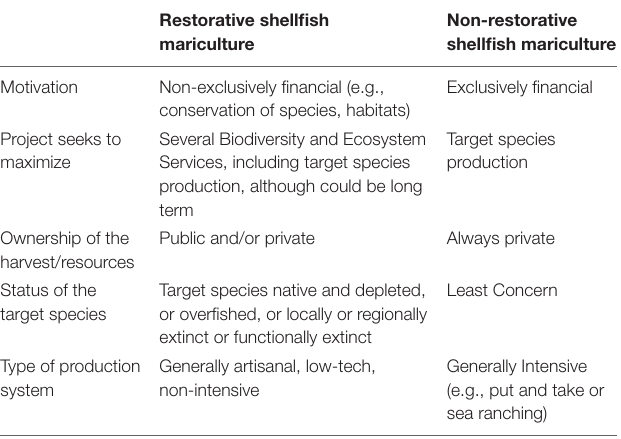
FIGURE 1 | (A) Geographic location of RSM Projects analyzed ( N = 575, since some projects could not be geo-referenced); (B) Ecoregion-based RSM effort, showing the relative number of